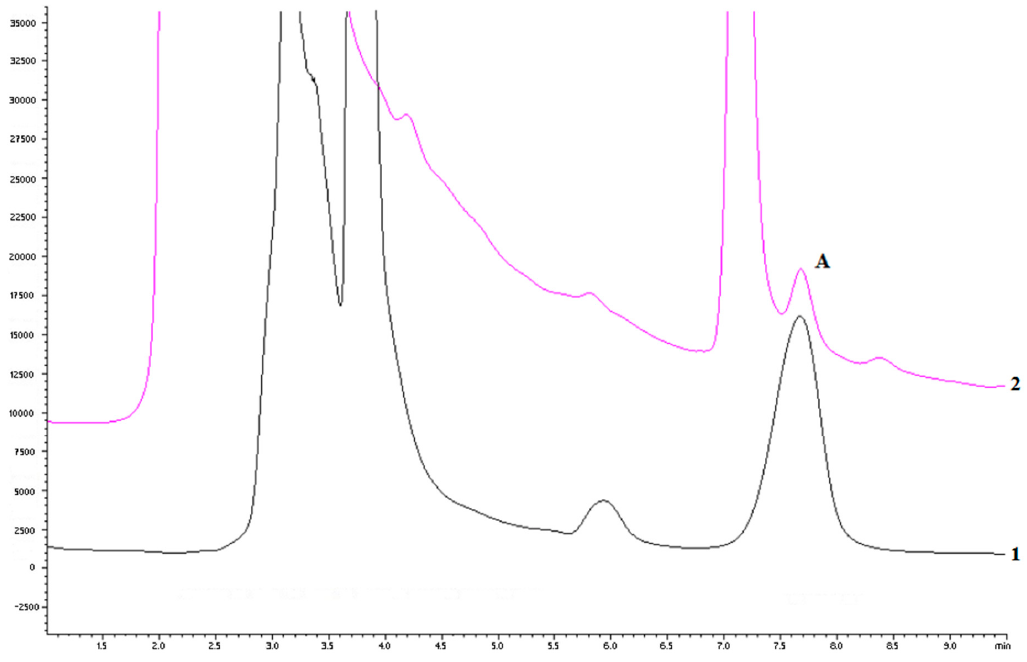
Figure 3. Chromatogram of syrup sample without SPE (2) pretreatment and with SPE (1), A- hederacoside.